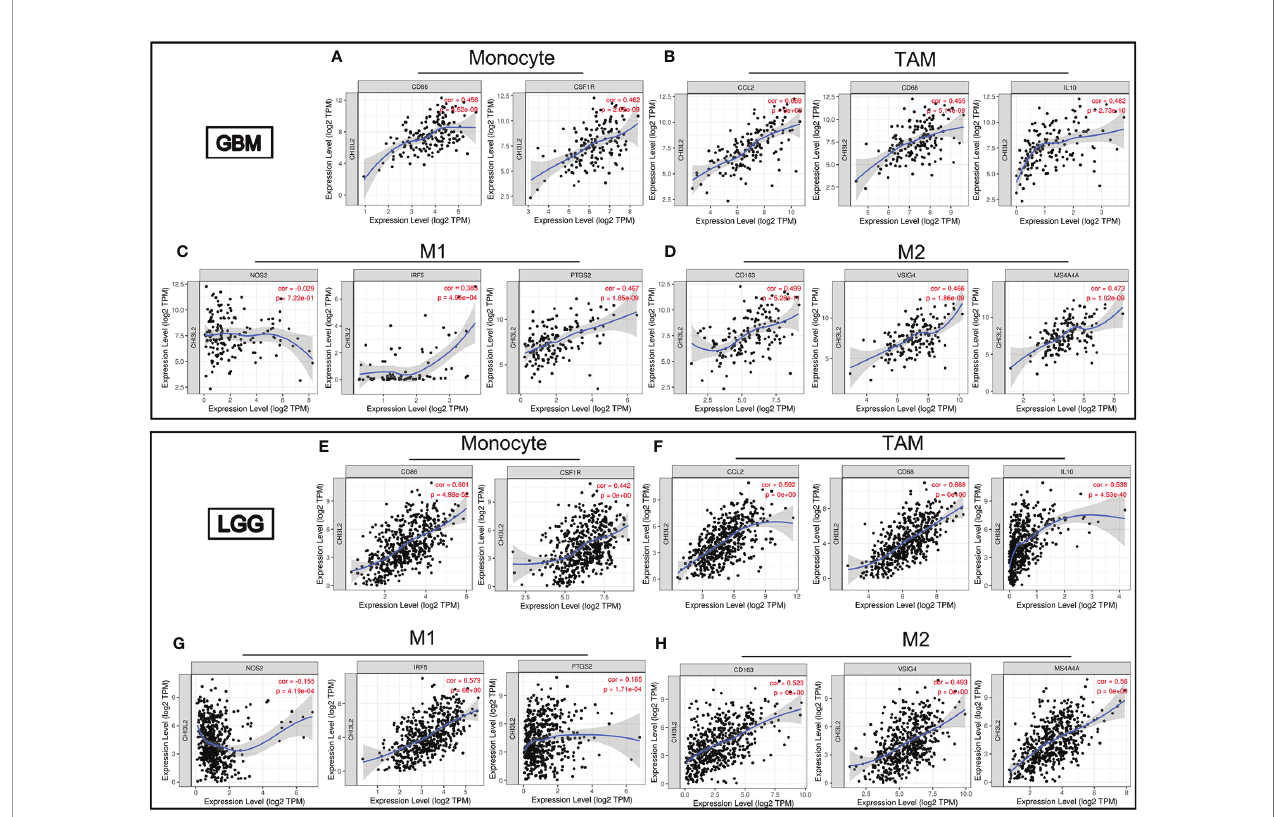
FIGURE 7 | CHI3L2 expression correlates with marker sets of immune cells in GBM and LGG. Scatter plots illustrate correlations between CHI3L2 and markers of monocytes (CD 86 and CSF1R), TAMs (CCL2, CD68 and IL10), M1 (NOS2, IRF5, and PTGS2), and M2 macrophages (CD163, VSIG4, and MS4A4A) in GBM (A – D) and LGG (E – H) .